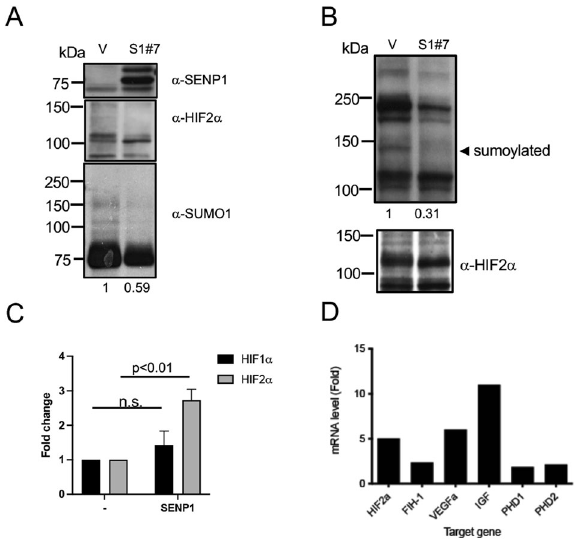
Fig. 3 SENP1 overexpression alters HIF2 α sumoylation. A SNEP1- overexpressing 786-O cells (S1#7) and vector control cells (V) were lysed in IP buffer and analyzed by immunoblotting with the indicated antibodies. B The samples as in A were denatured by boiling in 1% SDS buffer and processed for IP analysis with anti- HIF2 α antibody and sumoylation of HIF2 α was assessed by immunoblotting using anti-SUMO1 antibody. The numbers under immunotblots represent the quanti fi cation of total sumoylated proteins above the major ~75 kDa band (A) or a sumoylated HIF2 α (arrowhead pointed). C A HRE-Luc reporter was transfected into parental 786-O cells with HIF1 α , HIF2 α , or SENP1 expression constructs, and the resulting luciferase activity was measured after 48 h. The graph shows the fold change of luciferase activity normalized by the activity of HIF1 α or HIF2 α alone transfected cells. This was performed as duplicates, three-independent expreiments, and represented as ±SEM. D qRT-PCR analysis of indicated genes was performed using SENP1-overexpressing (S1#7) cells. The graph shows the fold change of the expression of indicated genes in SENP1-overexpressing cells relative to vector control